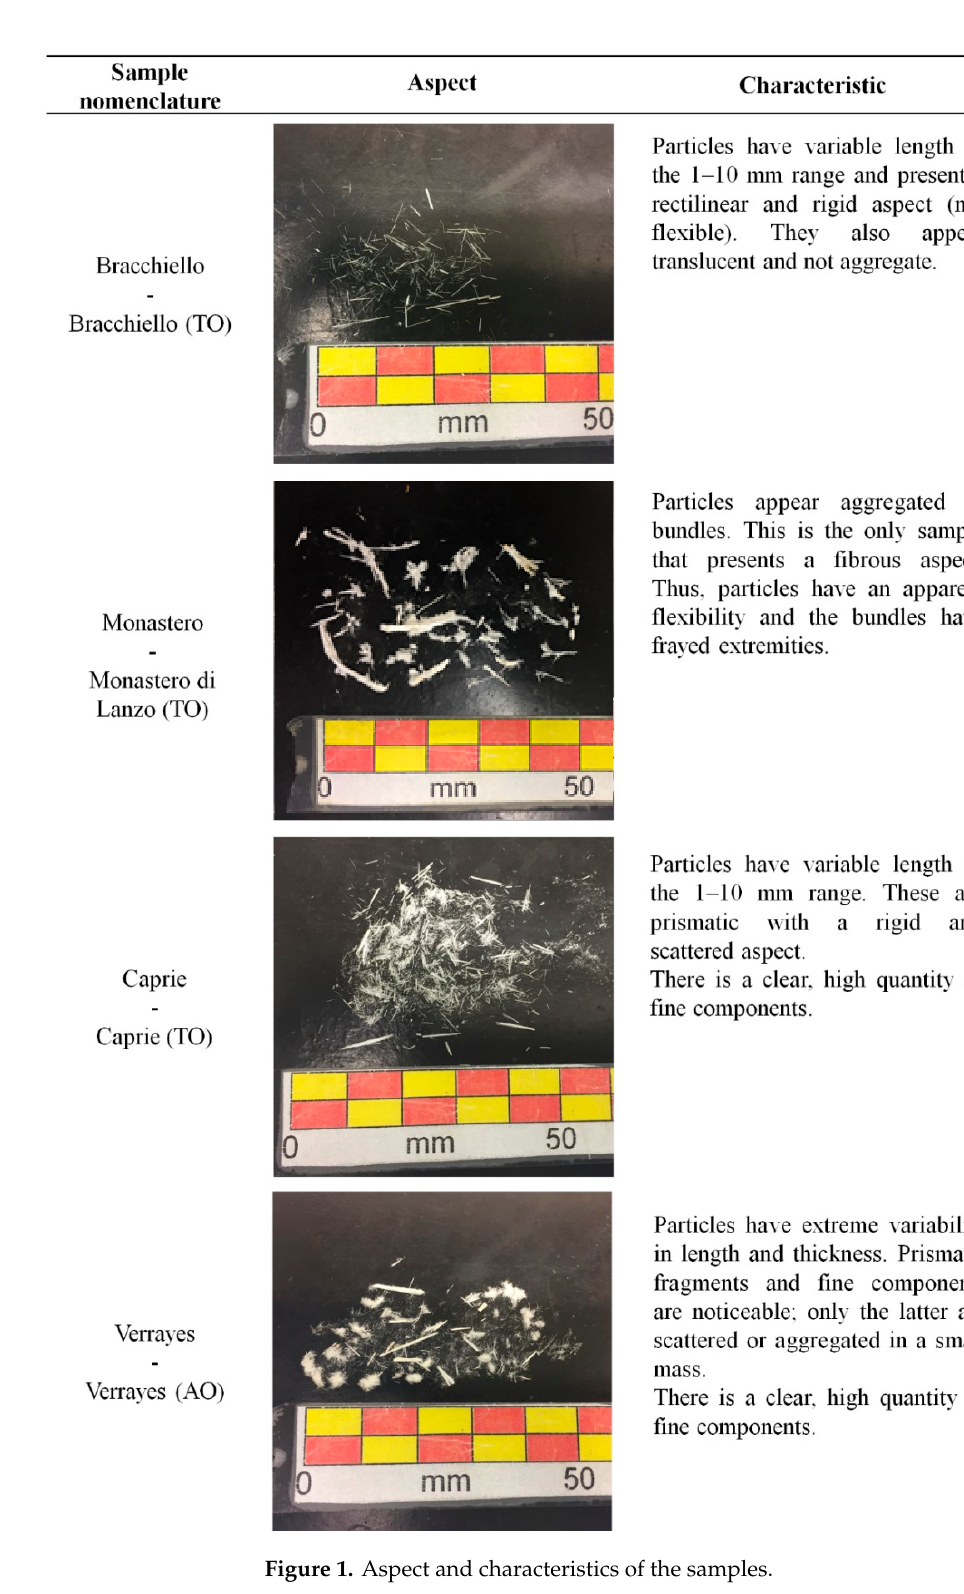
Figure 1. Aspect and characteristics of the samples.